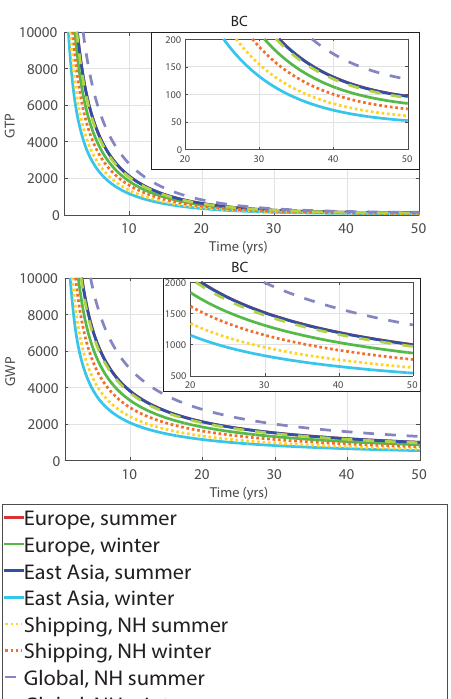
times of the SLCFs. The response of the SO 2 emissions ap- pears to decay more slowly than for the NO x emissions be- tween 50 and 100 years, which might not be expected